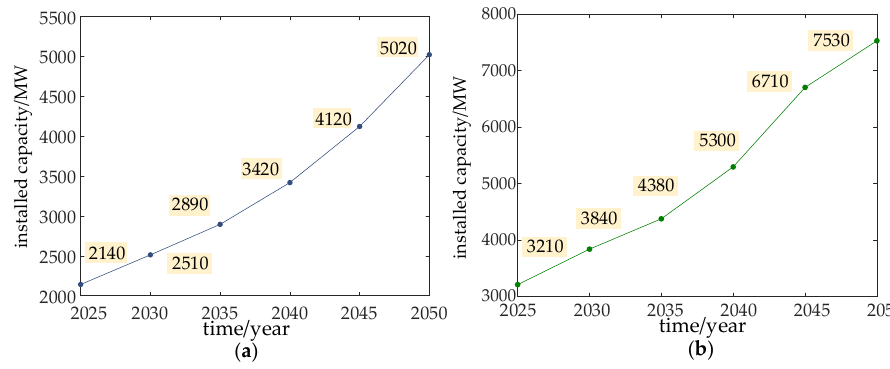
Figure 11. The planning capacity of electrolysis. ( a ) scenario 2; ( b ) scenario 3.